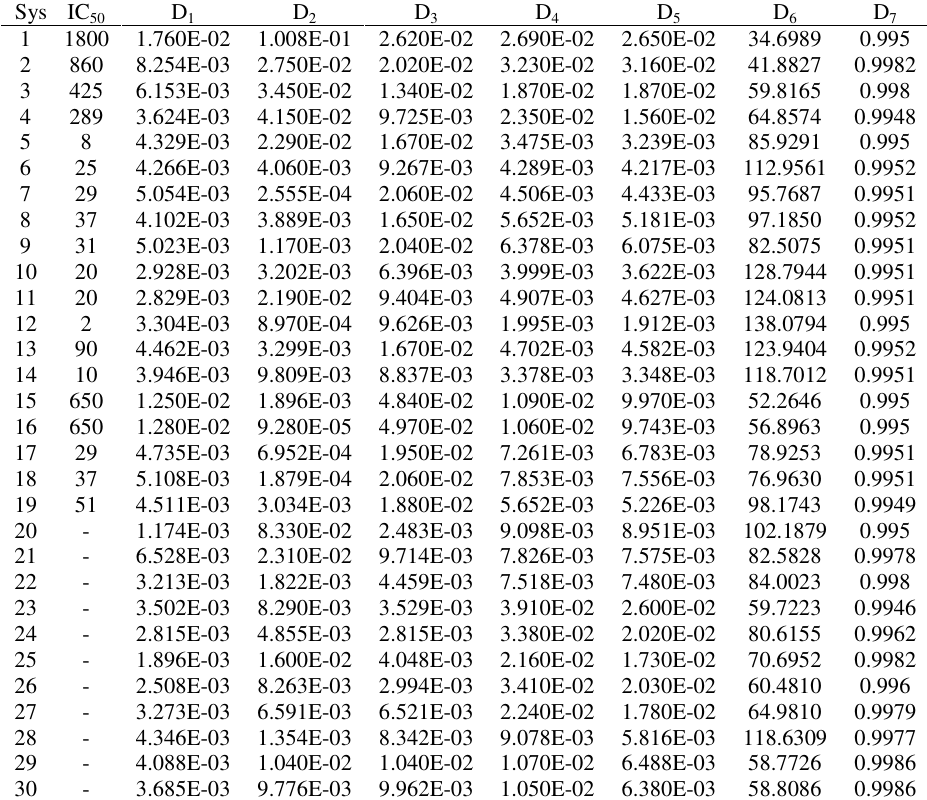
Table 2. The 15-Lipoxygenase inhibitory activity (IC the organosulfurs in scheme 1 according to the QSAR models of eqs. 4 and 5